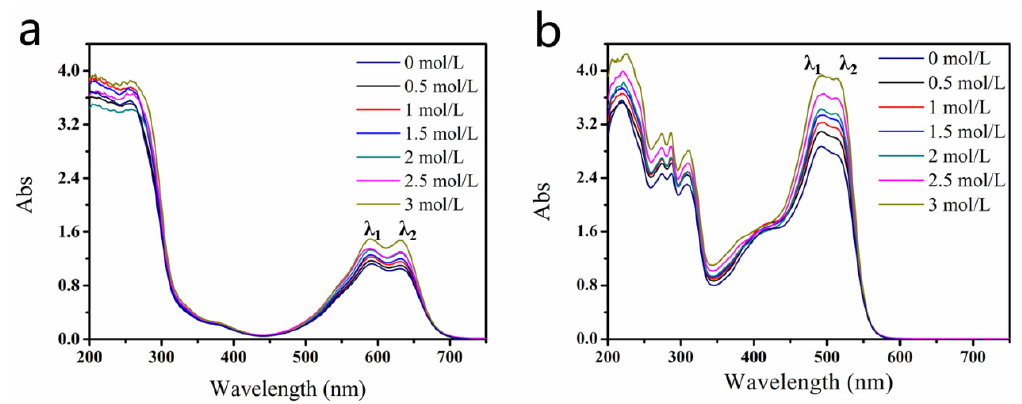
Figure 2. UV–visible absorption spectra of dye solutions with different DEG amounts. ( a ) Blue 49, ( b ) Orange 13 (dye concentration, 120 mmol/L).